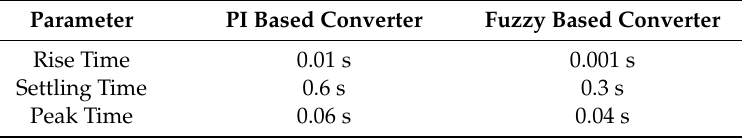
Table 9. Performance